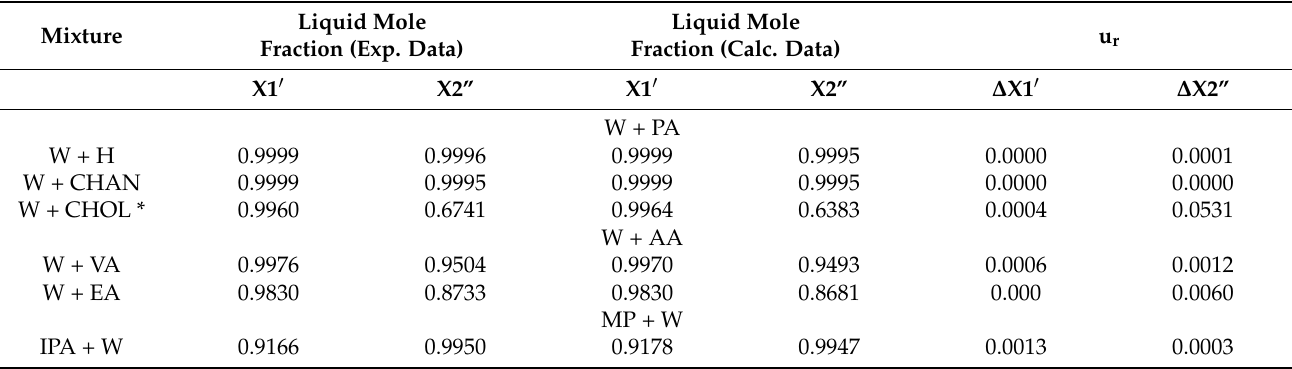
Table 3. The experimental and calculated LLE data (at 101.3 kPa, 293 K)